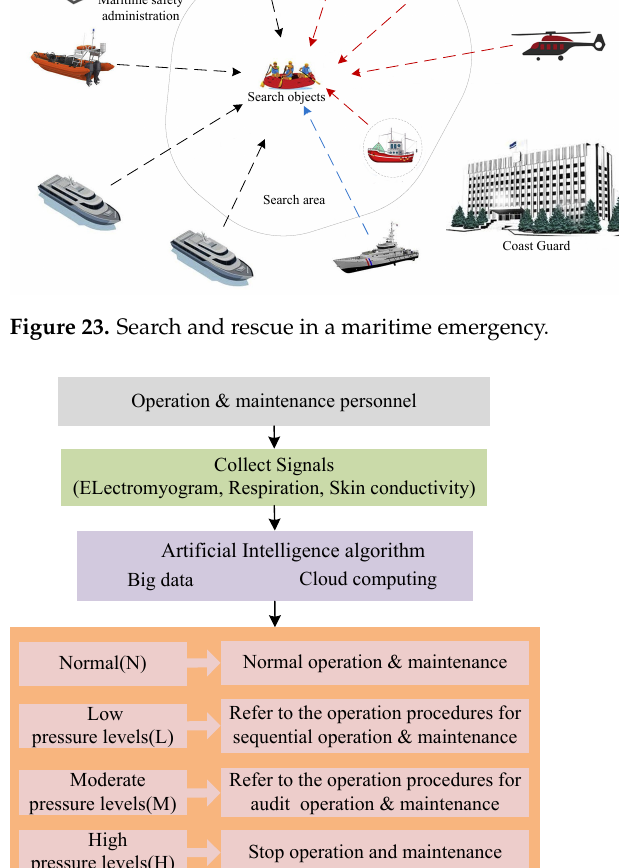
Figure 24. Operation and maintenance based on the pressure of operation and maintenance